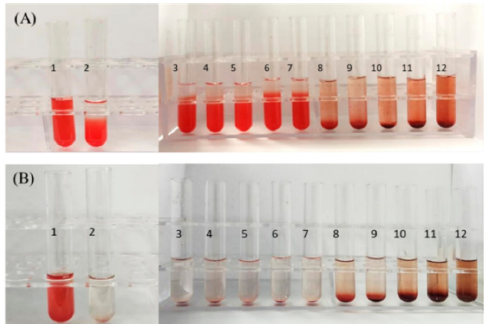
Figure 5. In vitro hemolysis results of RSANs after incubation of 3 h ( A ) and 24 h ( B ). Tube 1 was ultrapure water group, and tube 2 was the physiological saline group.